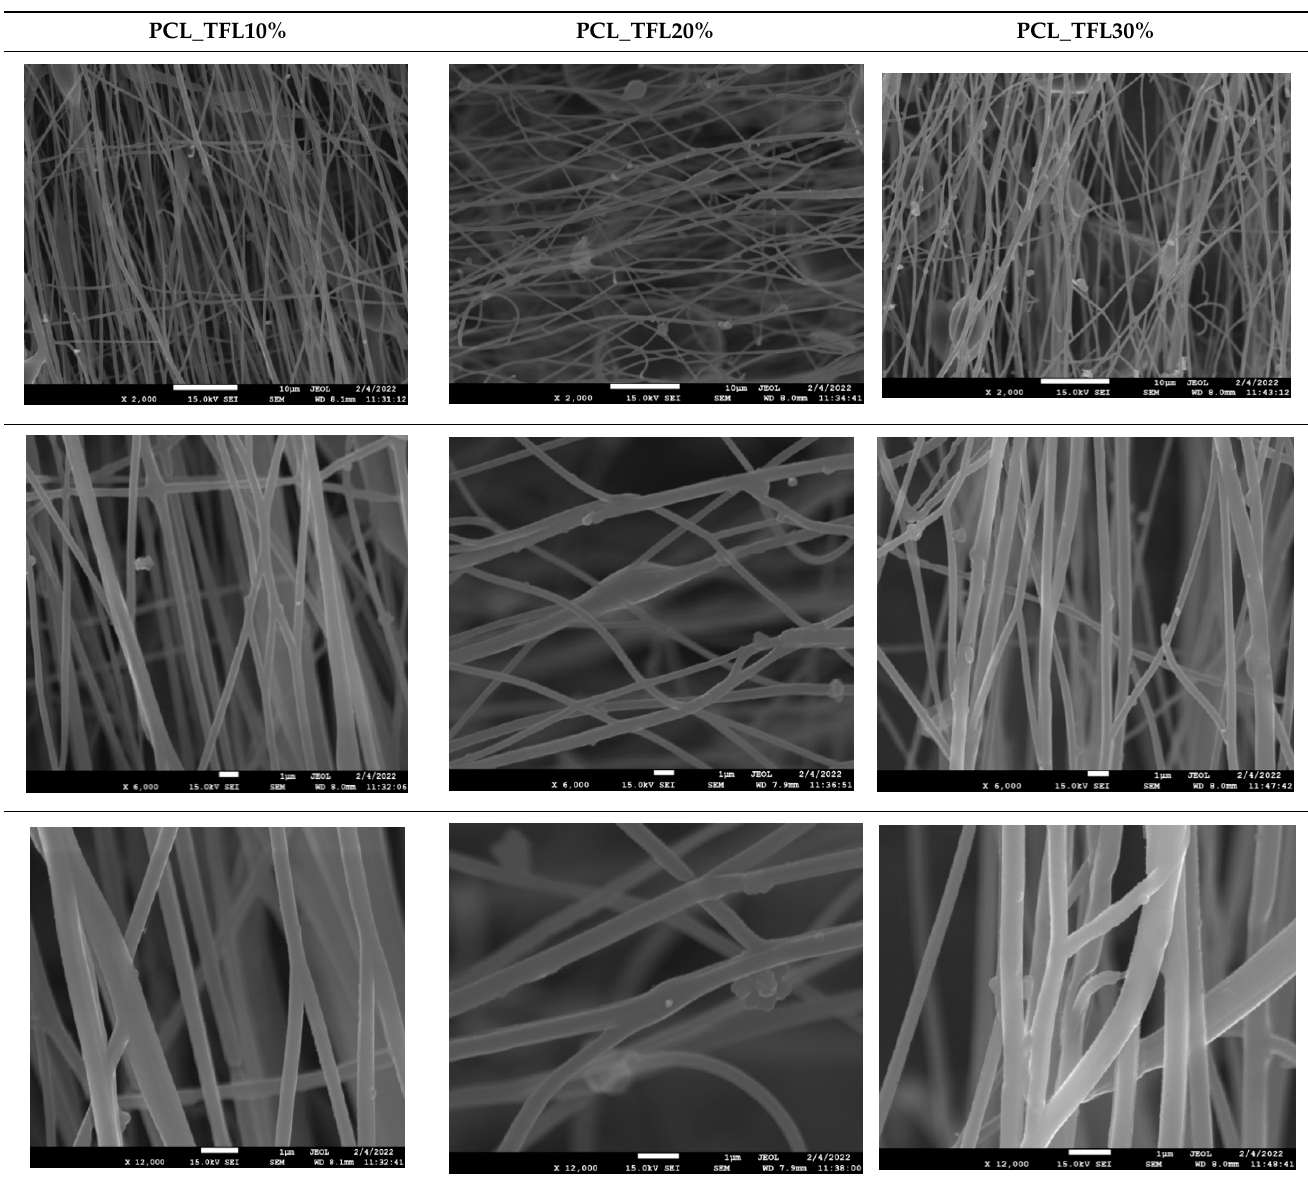
Table 6. SEM micrographs of PCL/TFL (10, 20 and 30%) loaded nanofibers.